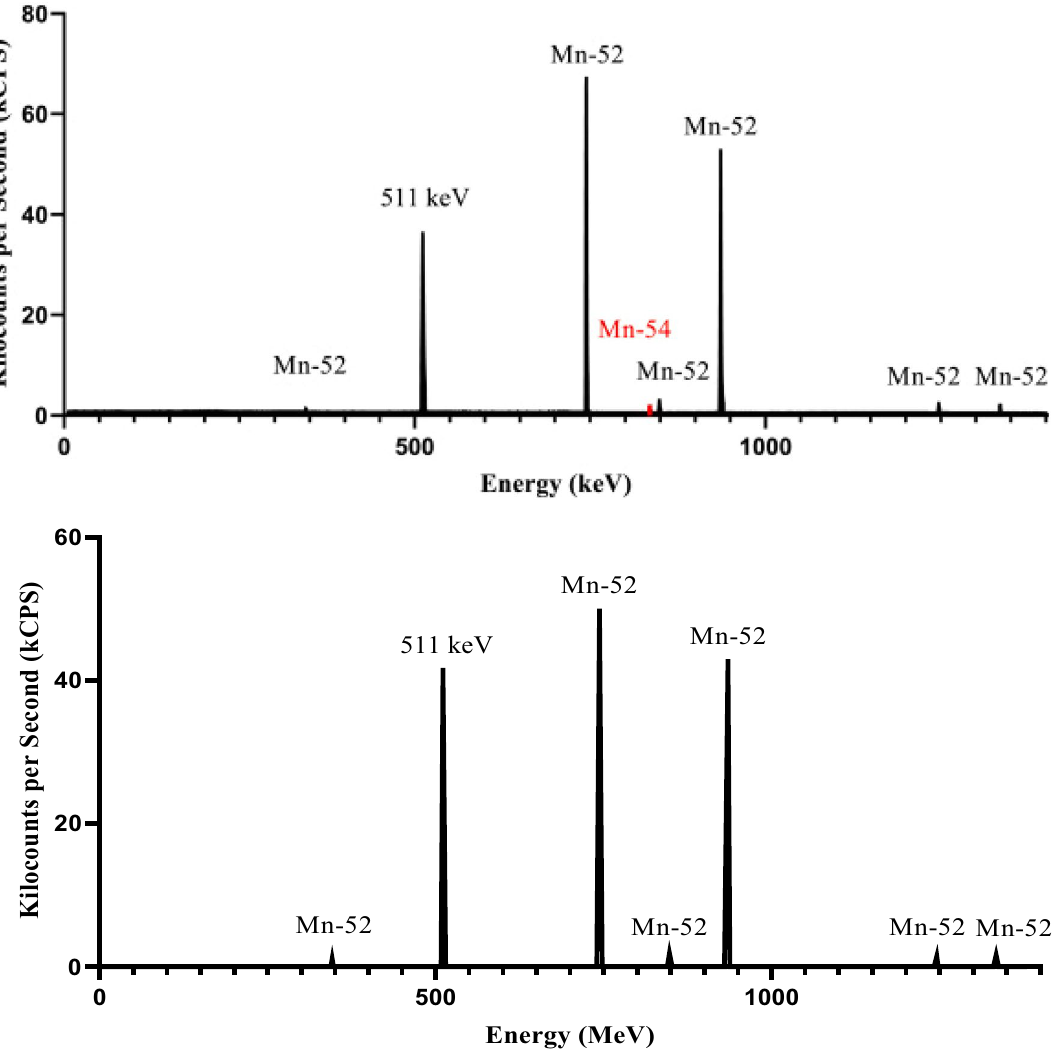
Figure 6. Top. Representative gamma spectra taken after the 52 Mn purification process of the natural Cr metal powder target (all natural targets discussed showed similar spectra with the same peaks) showing a lack of 51 Cr peak (320.1 keV). However, the 54 Mn peak (835.85 keV), highlighted in red, can still be observed as well as the many characteristic peaks of 52 Mn (345.8, 744.23, 847.7, 935.54, 1246.28, and 1333.65 keV) when natural Cr targets are used. Bottom. Representative gamma spectra taken after the 52 Mn purification process showing the absence of the 54 Mn peak when the enriched 52 Cr metal powder target was used 1,13